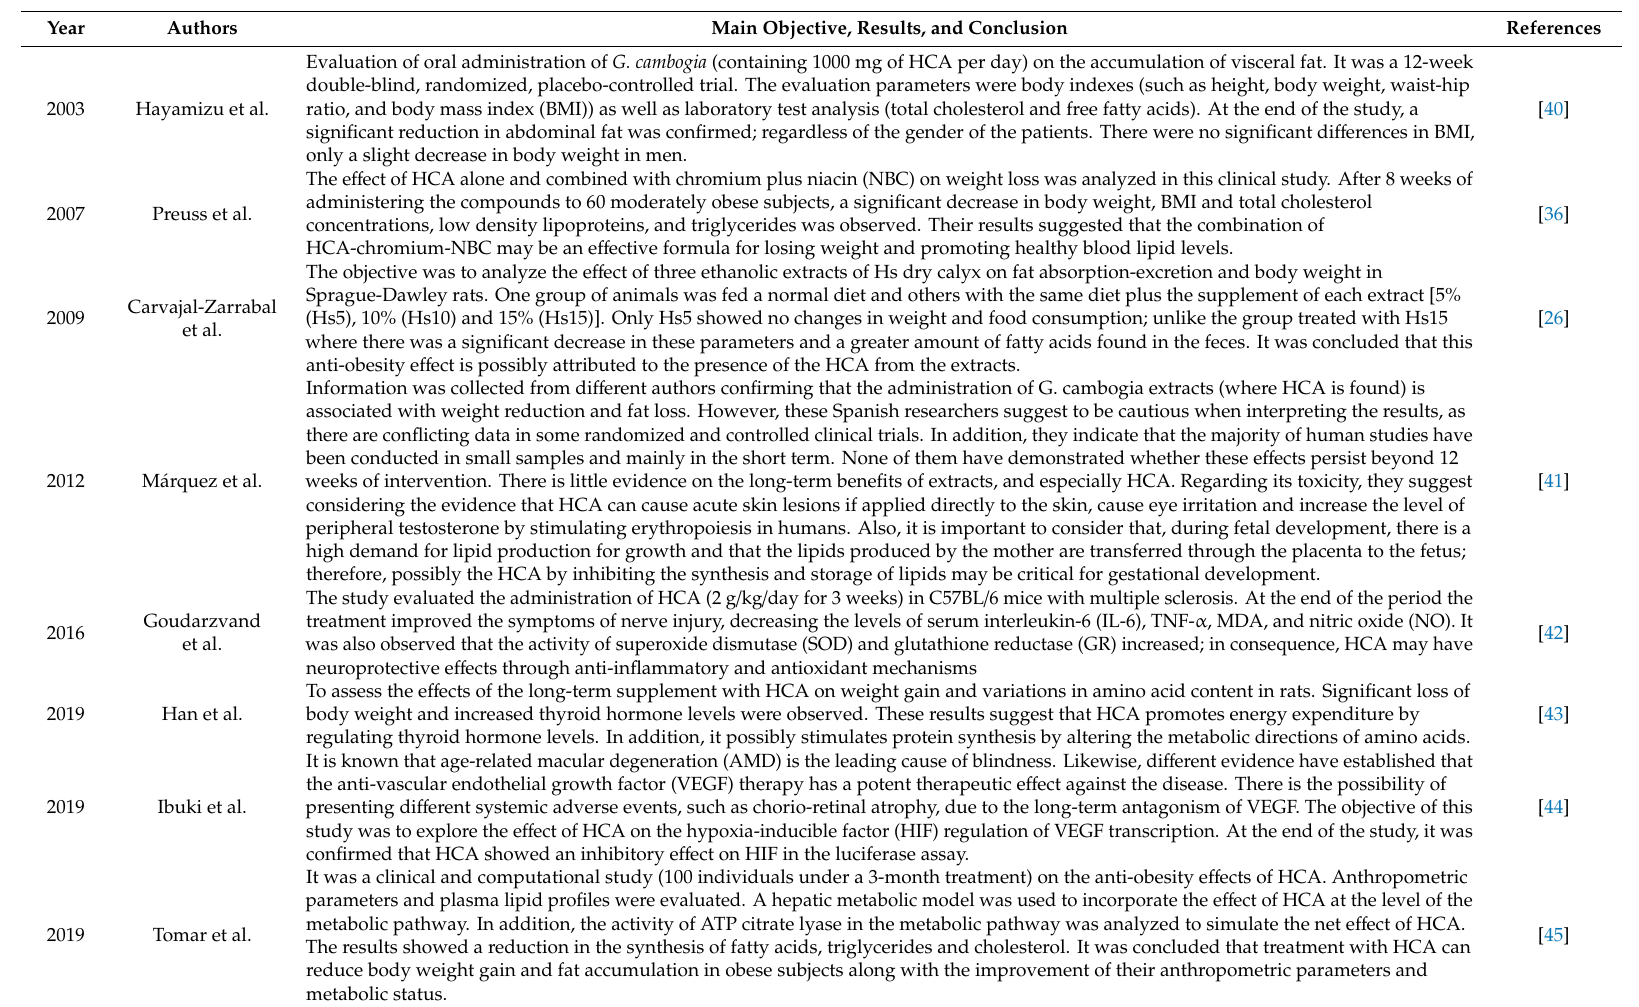
Table 4. Main therapeutic evidence of Hydroxycitric